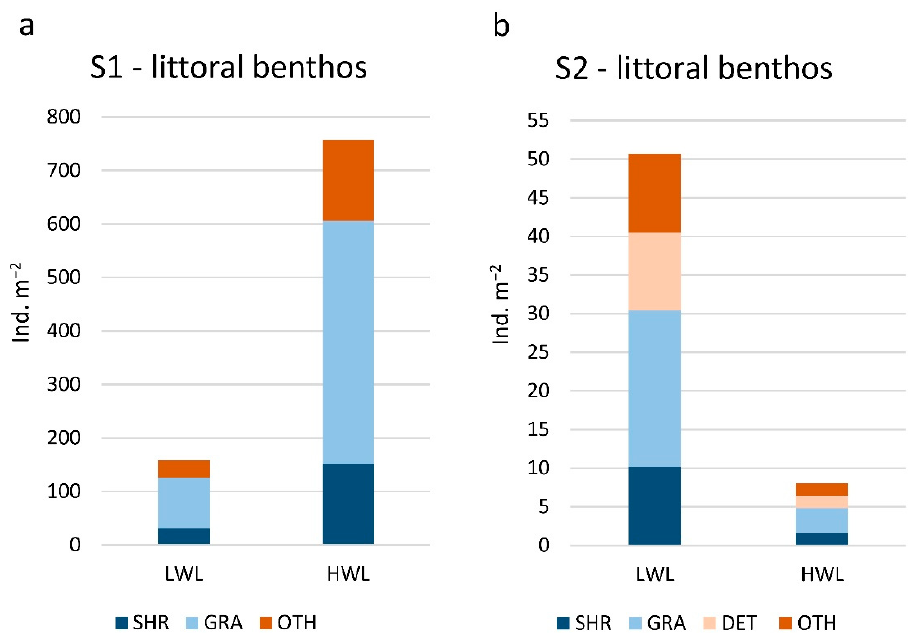
Figure 6. Gastropod functional feeding groups in the littoral benthal area of S1 ( a ) and S2 ( b ). Abbreviations are provided in Materials and Methods.